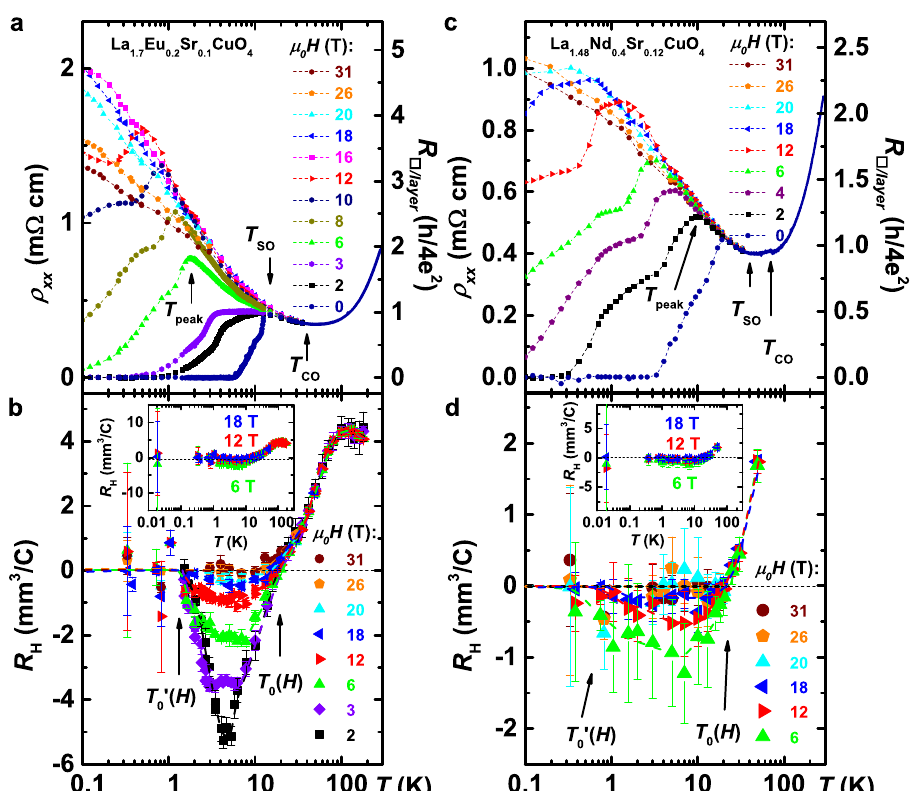
Fig. 3 Temperature dependence of the in-plane longitudinal resistivity ρ xx and the Hall coef fi cient R H for various perpendicular H . a , b ρ xx and R H , respectively, for La 1.7 Eu 0.2 Sr 0.1 CuO 4 ; the pseudogap temperature T PG ~ 175 K (ref. 55 ). c , d ρ xx and R H , respectively, for La 1.48 Nd 0.4 Sr 0.12 CuO 4 ; T PG ~ 150 K (ref. 55 ). The transition from the low-temperature orthorhombic to a low-temperature tetragonal structure occurs at T d2 ~ 125 K in La 1.7 Eu 0.2 Sr 0.1 CuO 4 and T / ln ð 1 = T Þ , as discussed in more detail elsewhere 3 3 ). The data in a and c are from refs. 3,4 . At the highest fi elds, ρ xx d2 ~ 70 K in La 1.48 Nd 0.4 Sr 0.12 CuO 4 (ref.